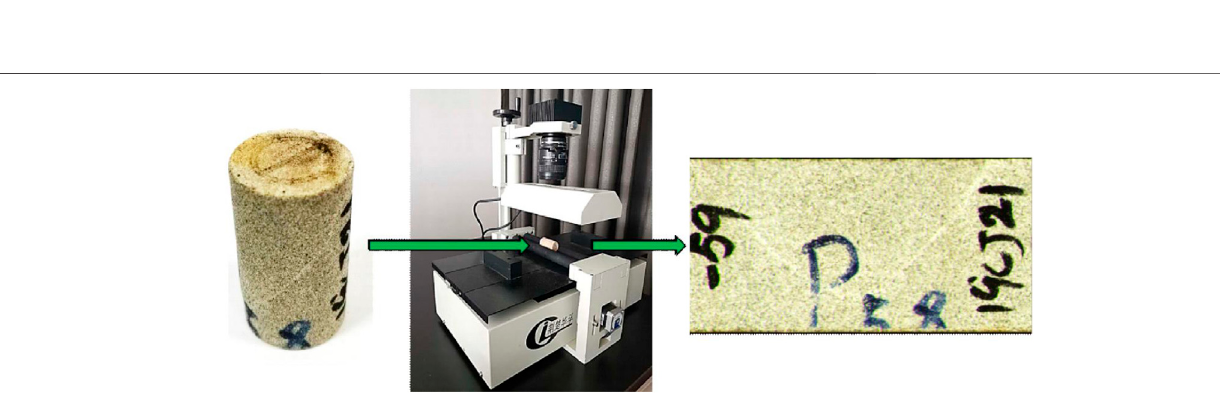
FIGURE 5 | JB-PDC core optical image scanner and its